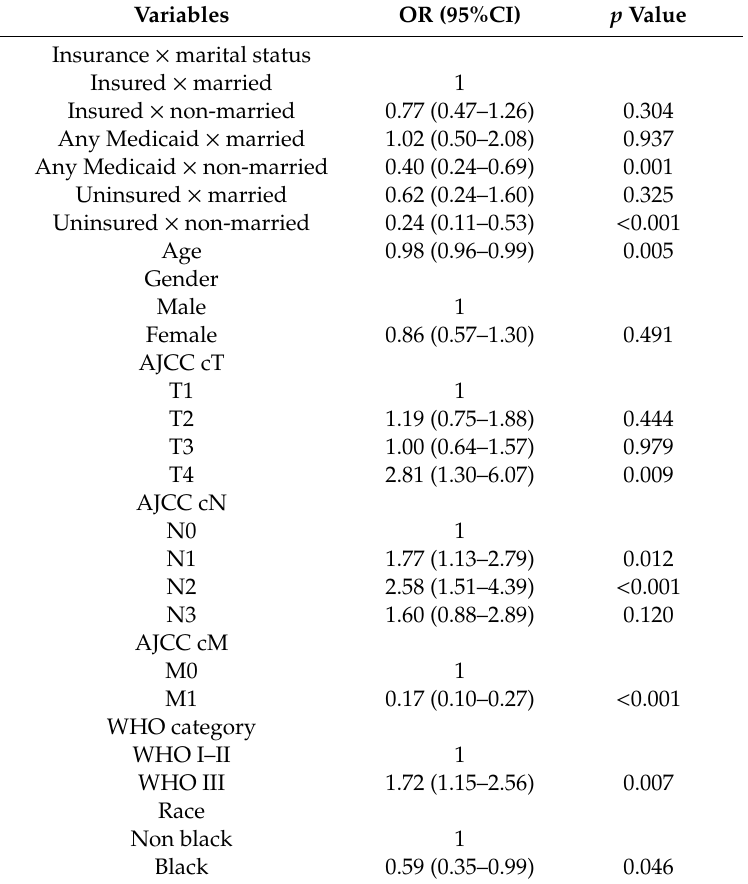
Table 3. Adjusted odds ratios for the association between variables and the opportunity of radiotherapy.